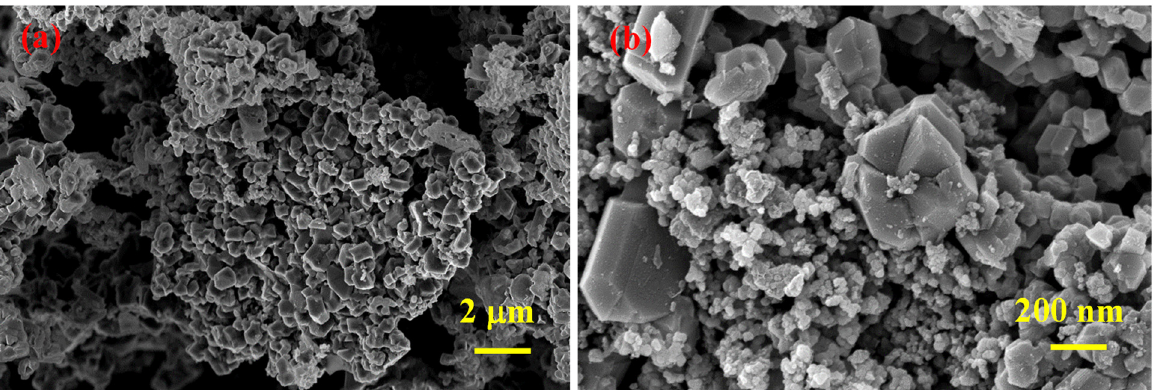
Figure 4. SEM micrographs of SHS-synthesized B 4 C powder after acid leaching at different magnifications ( a , b ).